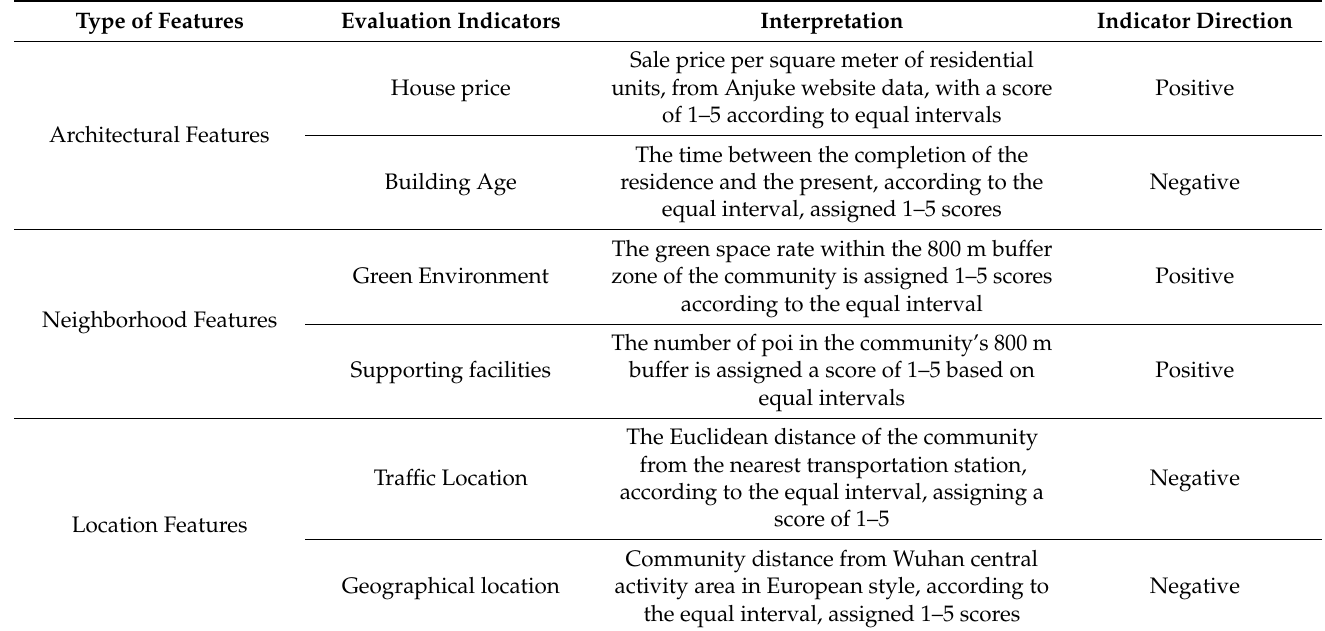
Table 2. Classification of Urban